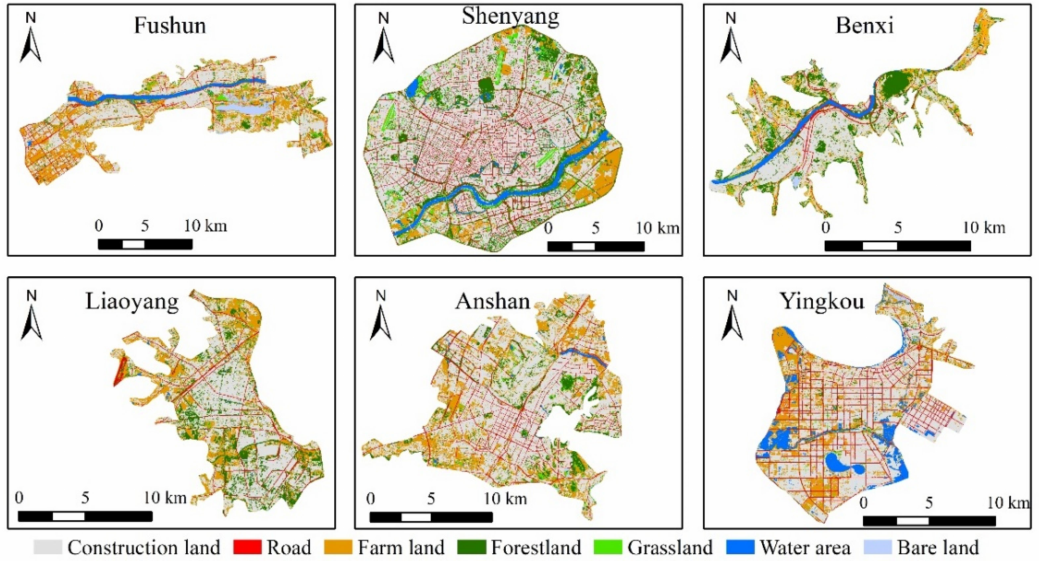
Figure 2. The land use map of the built-up area of the six cities.